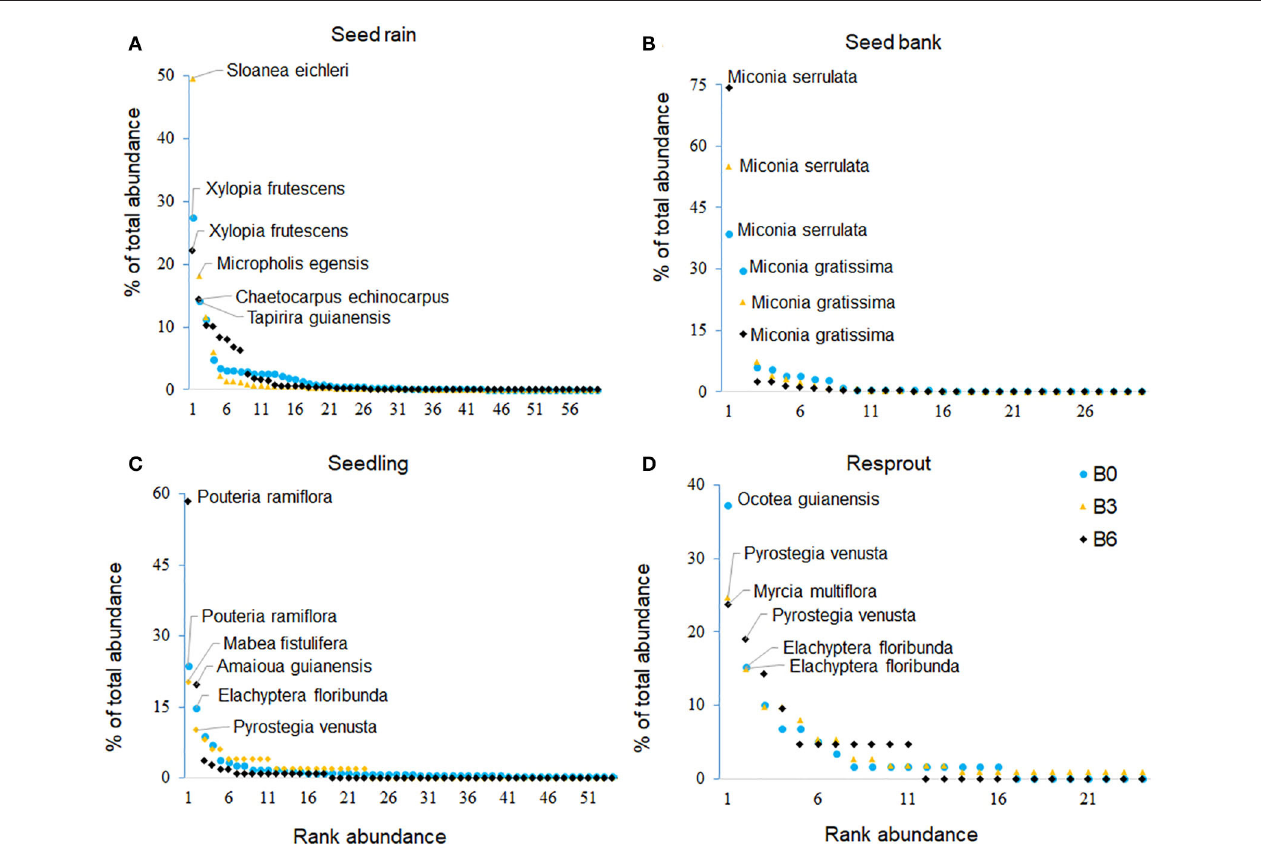
FIGURE 4 | Whittaker’s plot (rank-relative abundance diagram) of woody species (trees and lianas) sampled from the seed rain (A) , seed bank (B) , seedlings (C), and resprouts (D) . The two more abundant species by treatment were identified in the plot. B0 (control ) was not burned, B3 was burned three times with 3 years interval, and B6 was burned annually, six